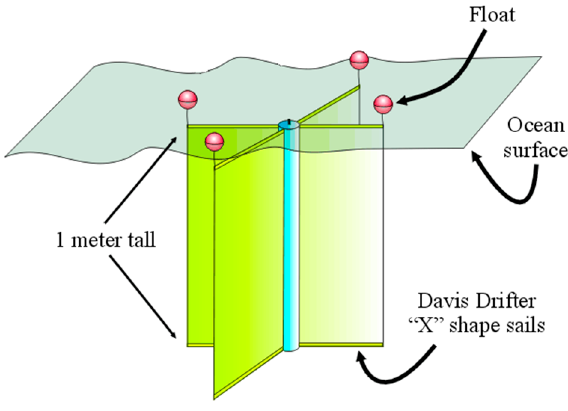
Figure 9. Davis drifter buoy design. Modified from http://www.ims.uaf.edu/NPRBdrifters.